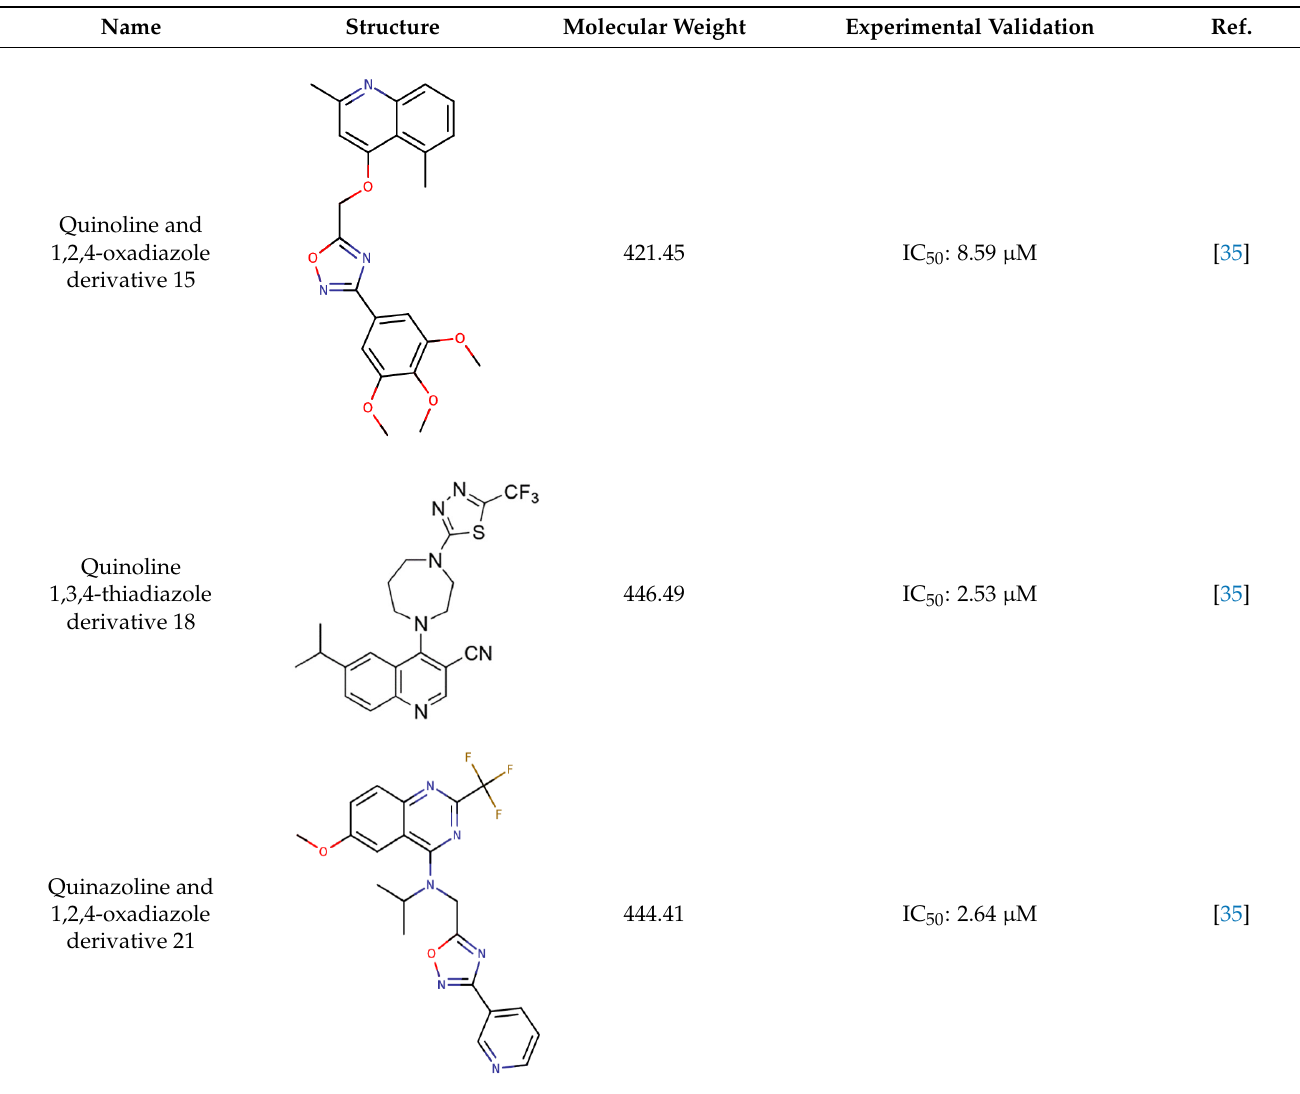
Table 1. Summary of potential P-gp inhibitors detected by computational studies reviewed in this manuscript. Structure Molecular Weight Experimental Validation Ref.